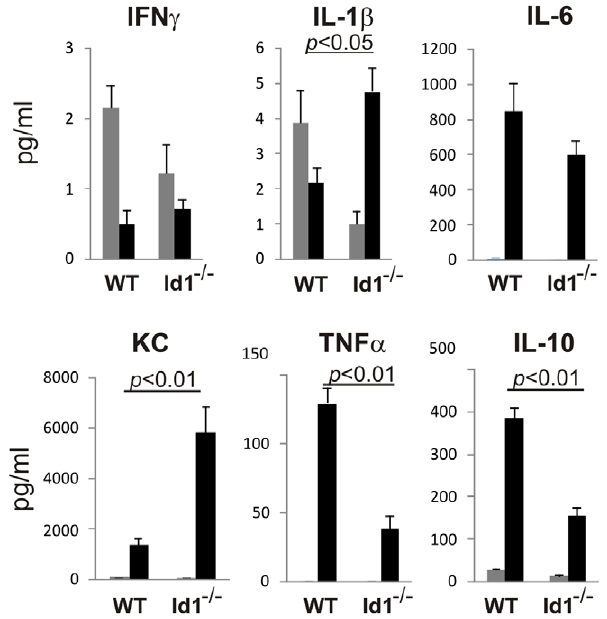
Figure 1. Cytokine production induced by chronic LPS stimulation. Serum samples (n . 6) were collected from indicated strains of mice untreated (grey bar) or treated with a daily dose of 1 m g LPS for 15 days (black bar). Indicated cytokines were measured using a multiplex assay kit as described in Method. Data shown are averages with SEM. The levels of cytokines induced by LPS in WT and Id1 2 / 2 mice were compared and statistically significant differences are indicated by showing the p